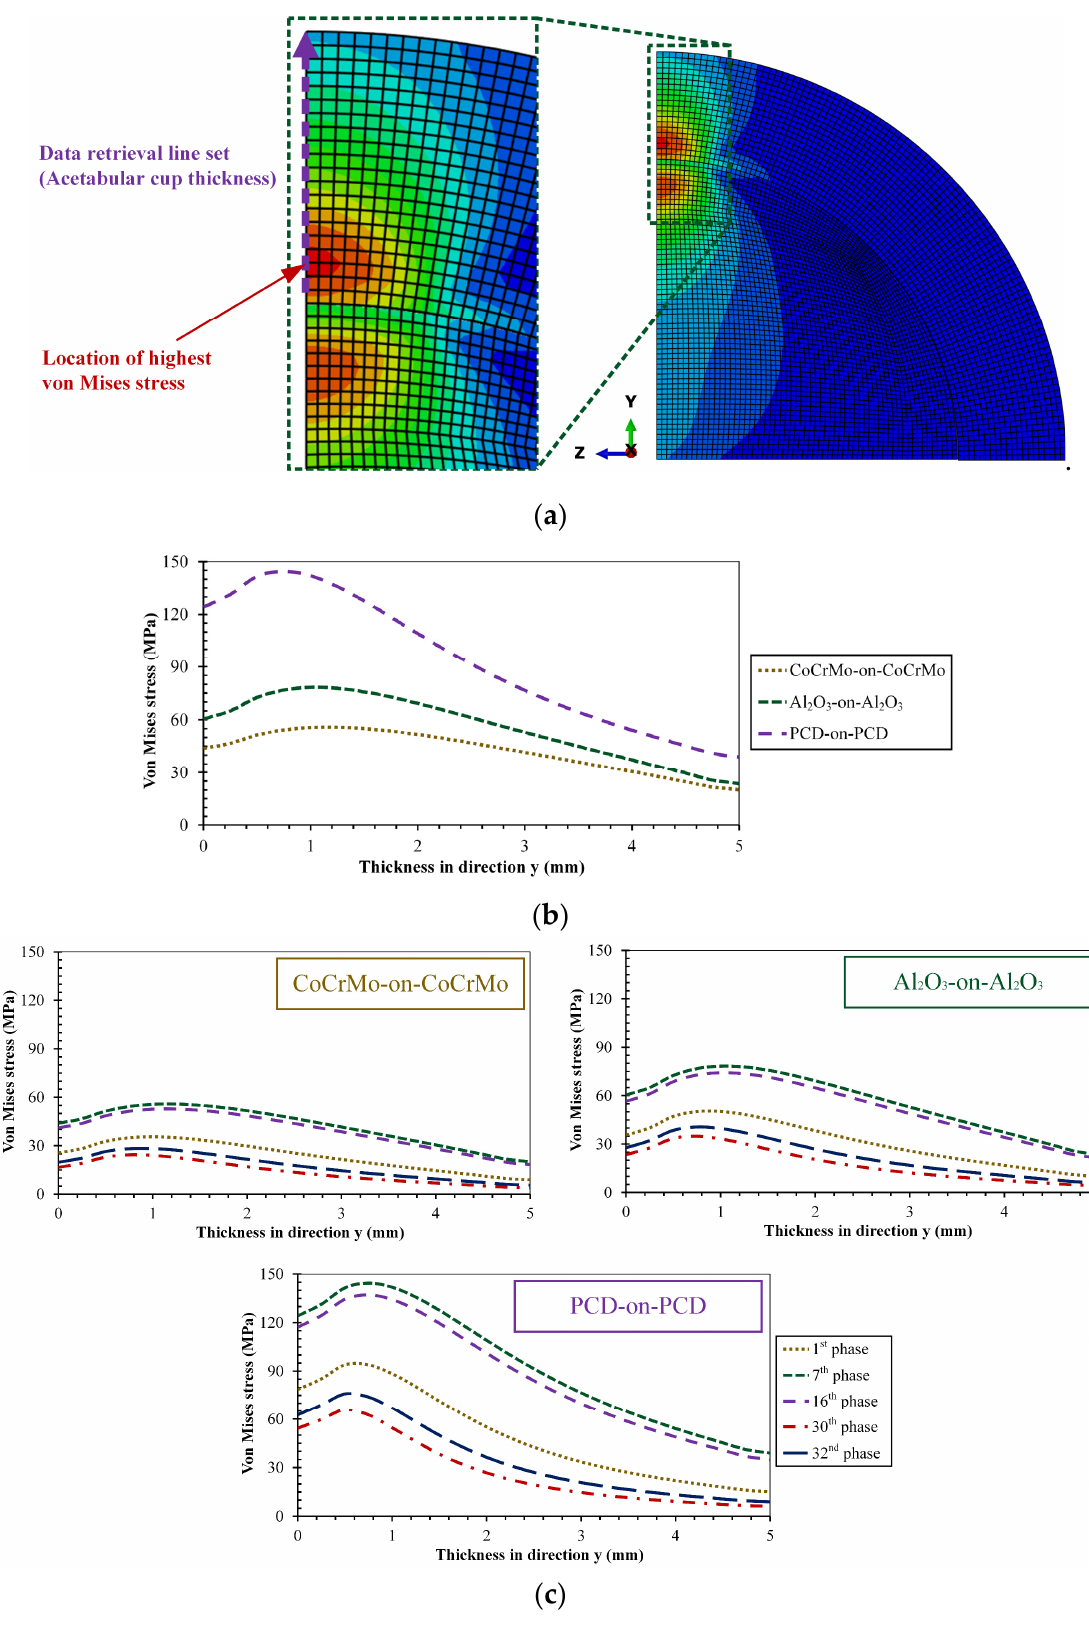
Figure 8. Von Mises stress profile as a function of acetabular cup thickness on hard-on-hard bearings: ( a ) Data retrieval line set, ( b ) profile at peak loading, and ( c ) profile at selected